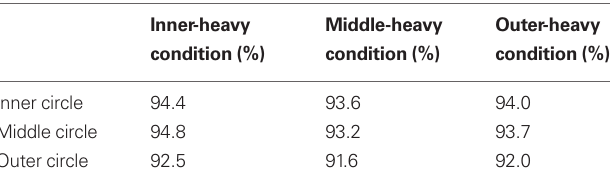
Table 1 | Accuracy as a function of probability distribution and stimulus location for trials with rT > 150 ms and < 1000 ms (as for the other